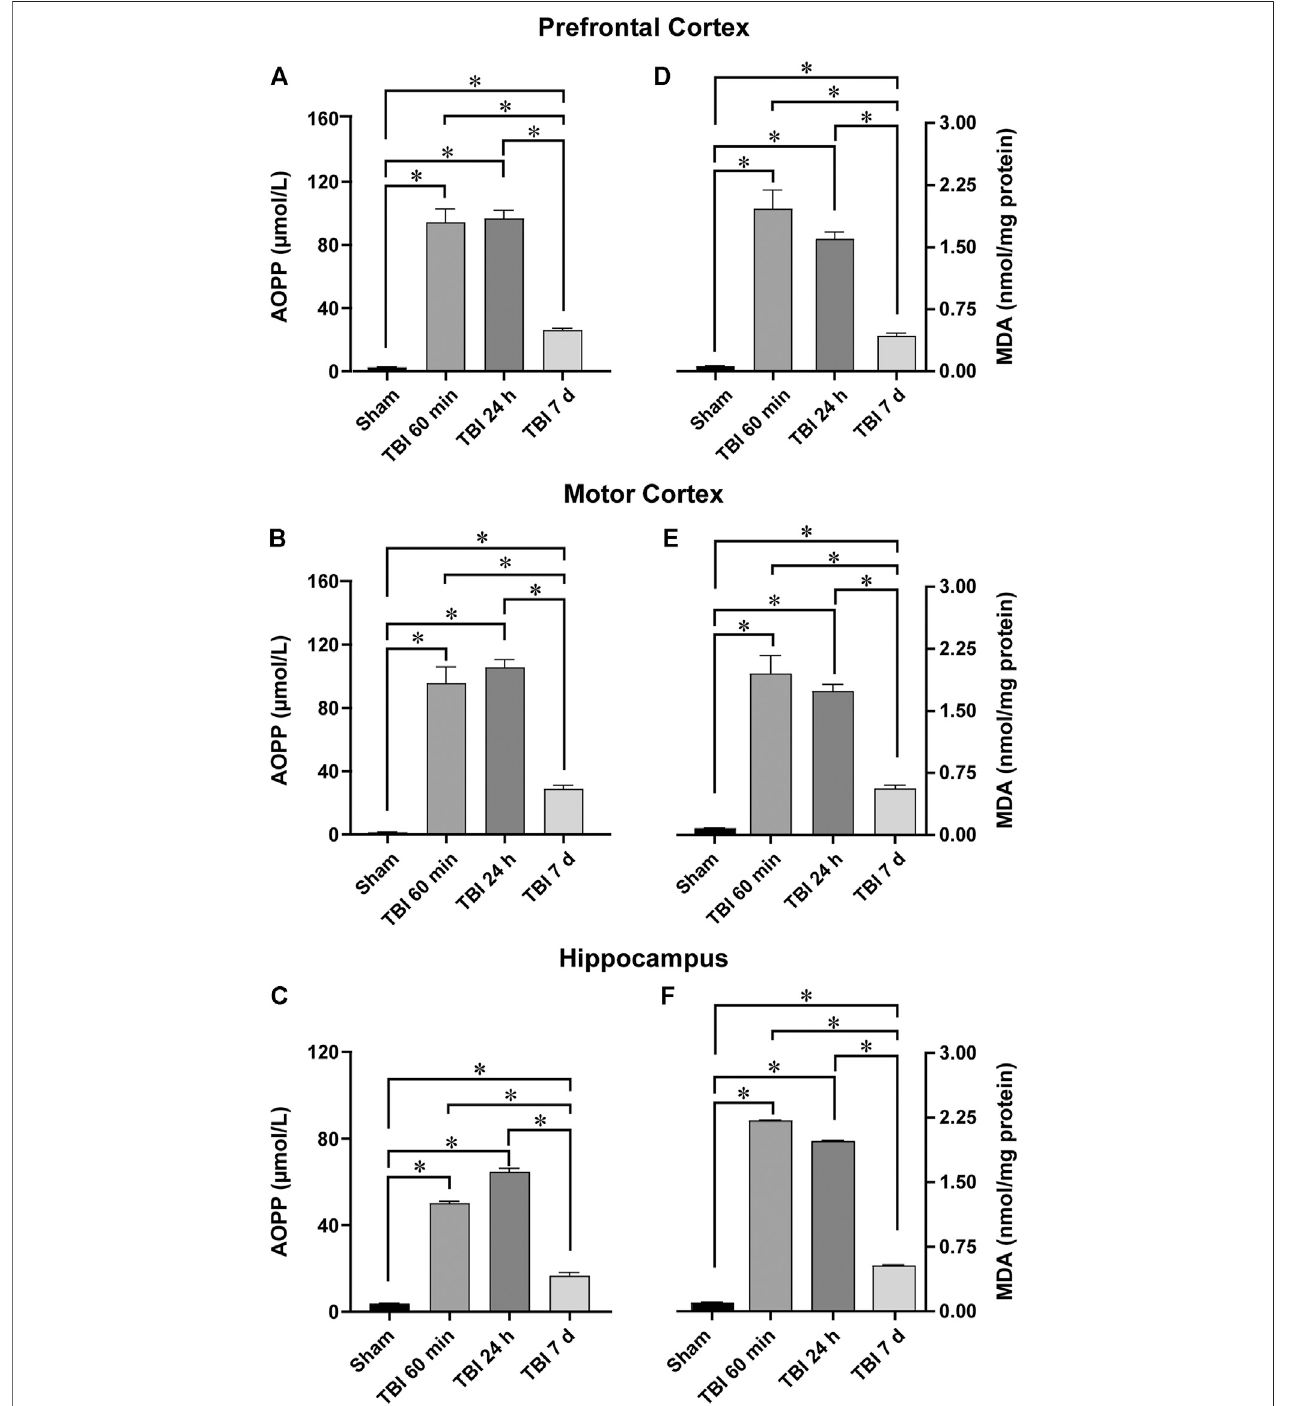
FIGURE 2 | TBI induces a persistent increment in OS biomarkers. The graphs show the AOPP and MDA quanti fi cation as measurements of lipid and protein peroxidation, respectively, in brain areas neighboring the trauma area, such as (A) and (D) Prefrontal cortex; (B) and (E) Motor cortex; and (C) and (F) Hippocampus . Bars represent the mean ± SEM; n (cid:2) 4. *Indicates signi fi cant difference ( p < 0.05).